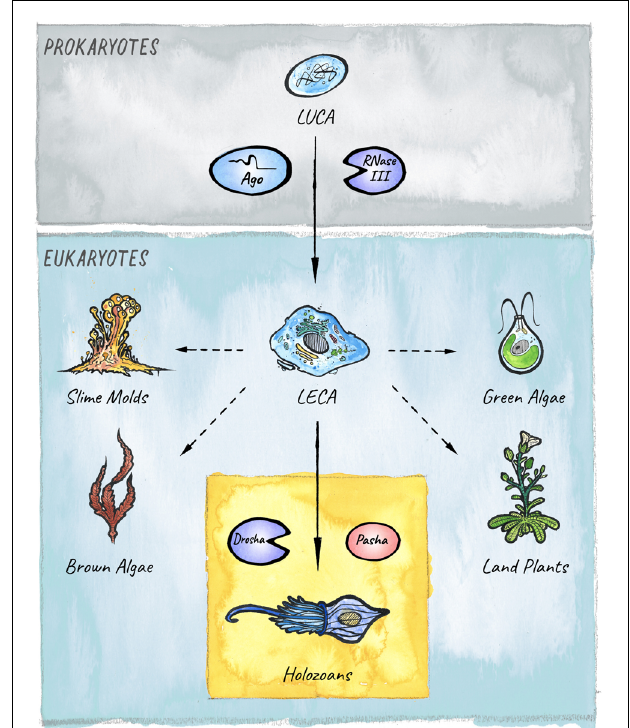
FIGURE 1 | The evolutionary origins of miRNAs in eukaryotes. Two key players in small RNA-mediated silencing, Argonaute proteins and RNase III like enzymes, originated in prokaryotes. The miRNA pathway in animals emerged with the birth of the Microprocessor, composed of Drosha and Pasha, in unicellular holozoans (Bråte et al., 2018). Diverse lineages that branched from the last eukaryotic common ancestor (LECA) also evolved miRNA-like pathways. However, it is still under debate whether these evolved independently in four additional clades: Slime molds, Green algae, Brown Algae, and Land plants (Kruse et al., 2016; Valli et al., 2016; Cock et al., 2017; Bråte et al., 2018); or if the pathway was already present in the last common ancestor (Moran et al.,